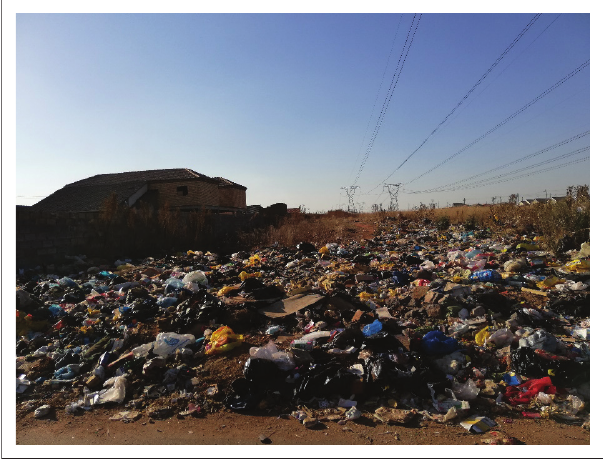
Source : Photo courtesy of Mamorwadi J. Kemp (21 July 2019) FIGURE 6: Illegal dumping in Protea